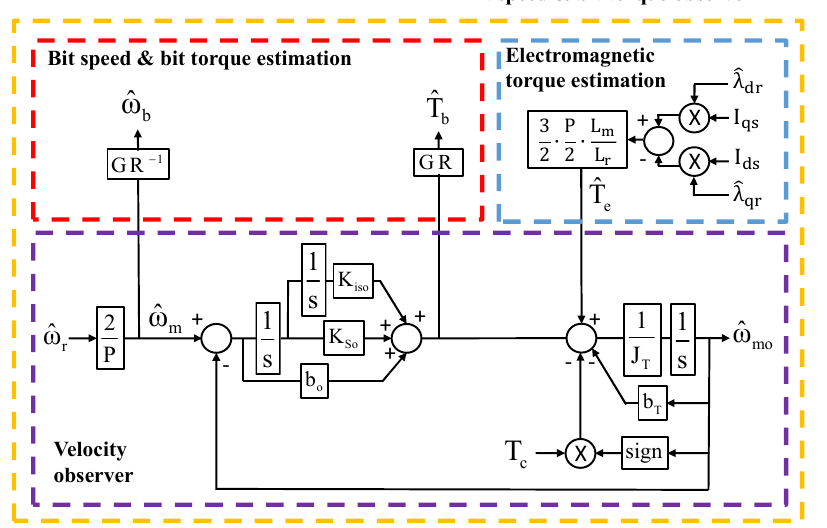
Figure 5. Block diagram of the bit speed and bit torque